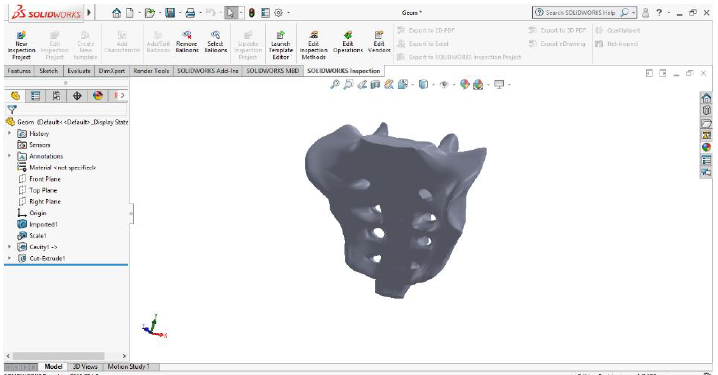
Figure 27. InVesalius interface for the second set of CT scans. This primary geometry in STL format was loaded into Geomagic software for pro- cessing and adaptation. At that time, the model contained 1,092,725 triangular primary surfaces. Figure 28 shows the interface of this program with the femur primary geometry loaded. Figure 28. Primary geometry of the femur in Geomagic.